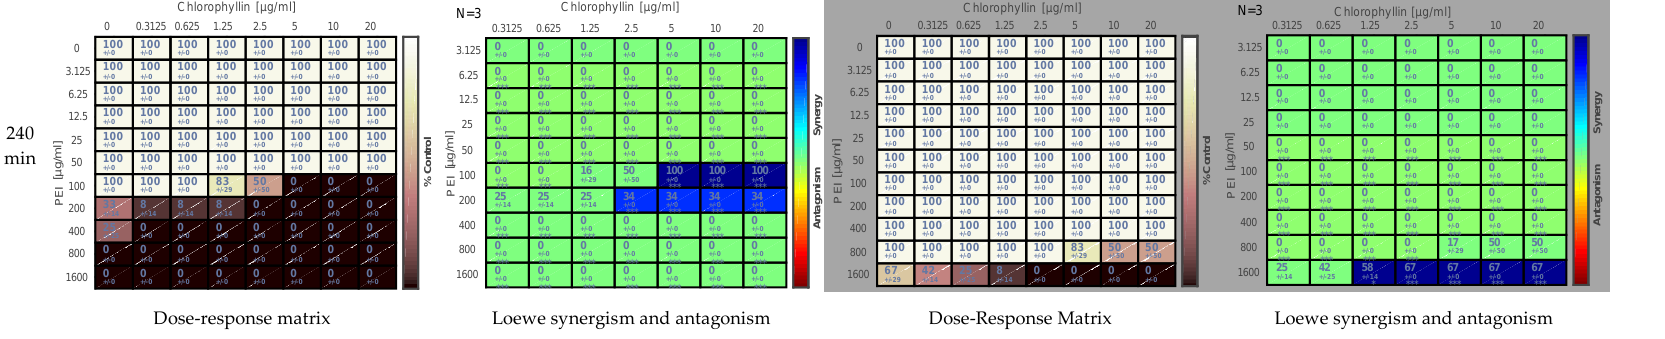
Figure 2. Effect of PEI and chlorophyllin combinations on E. coli DH5 α upon illumination with a blue-red light source (12.7 mW cm − 2 ) and in darkness at 0 min, 60 min, 120 min, and 240 min. of incubation. The dose-response matrix indicates the percentage of eradication (the darker the color, the higher the inhibitory effect). The Loewe synergism and antagonism for PEI-chlorophyllin combinations against E. coli DH5 α were determined using the Combenefit software. N represents the number of biological replicates in the matrix. Asterisks represent statistical significance: *: p < 0.05 and ***: p < 0.0001.